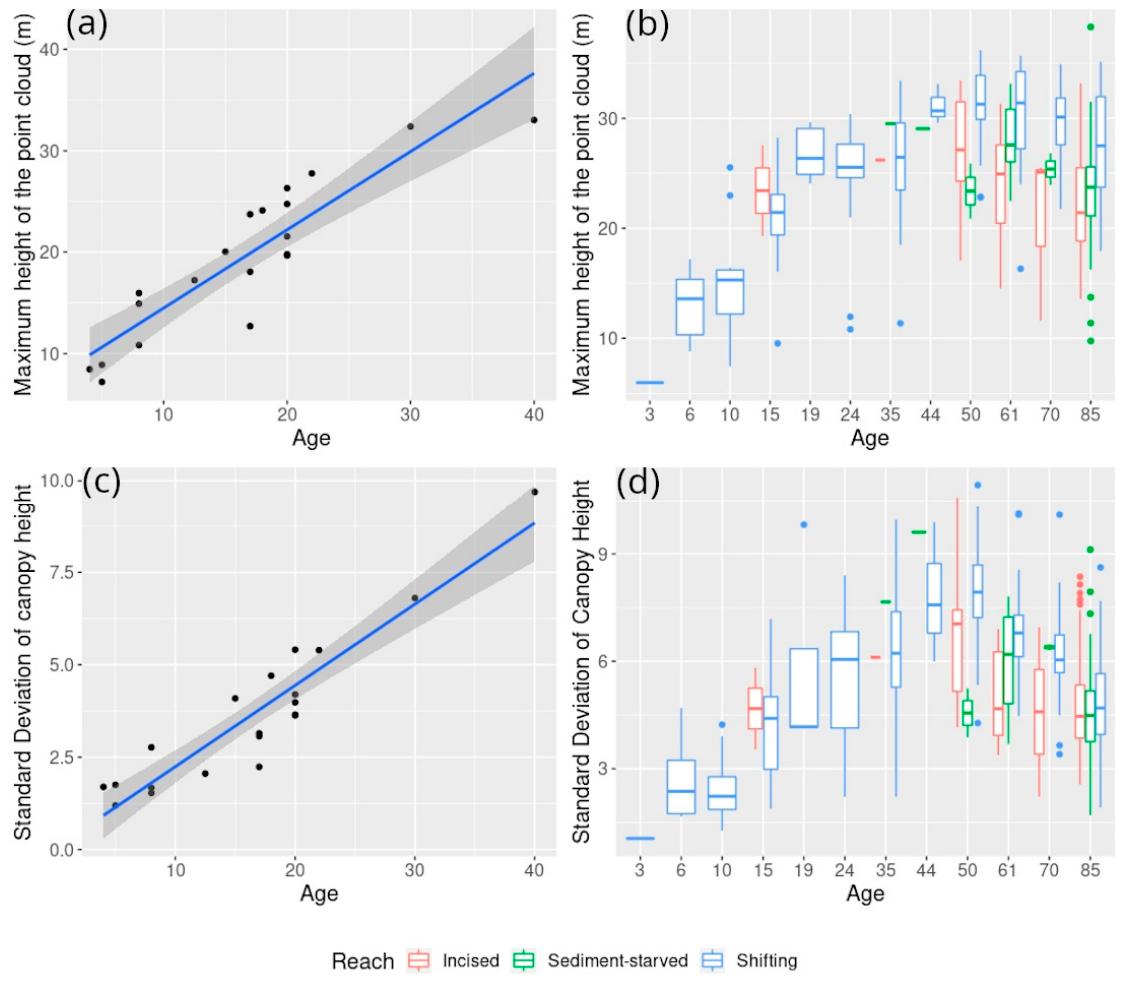
Figure 10. Relationships between structure (maxima and standard deviation of height) and age for the EVS plots on the age gradient ( a , c ), and for the ONF plots ( b , d ). The growth of the riparian forest with age is also visible in the plots from the ONF survey, even though the age of each individual plot is less homogeneous. Both the height of the canopy in the plots (Figure 10b) and its standard deviation (Figure 10d) increases with age, until it reaches a plateau in the case of height or decreases in the case of standard deviation at around 40 years. Once again, age is not the only explanatory factor, as forest plots on the incised or sediment-starved reaches tend to have a lower maximum canopy height, compared with plots of the same age in the shifting reach, as well as a lower standard deviation of canopy